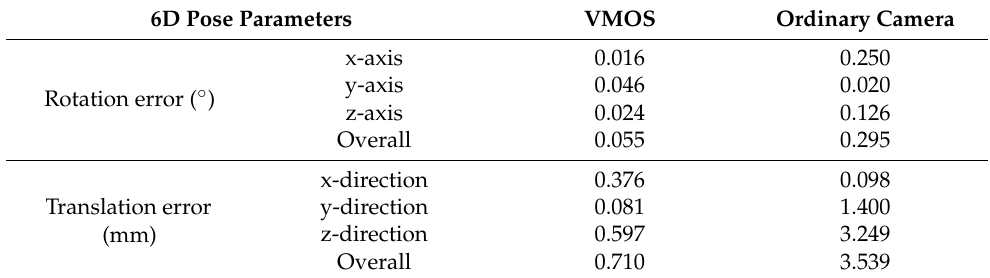
Translation error